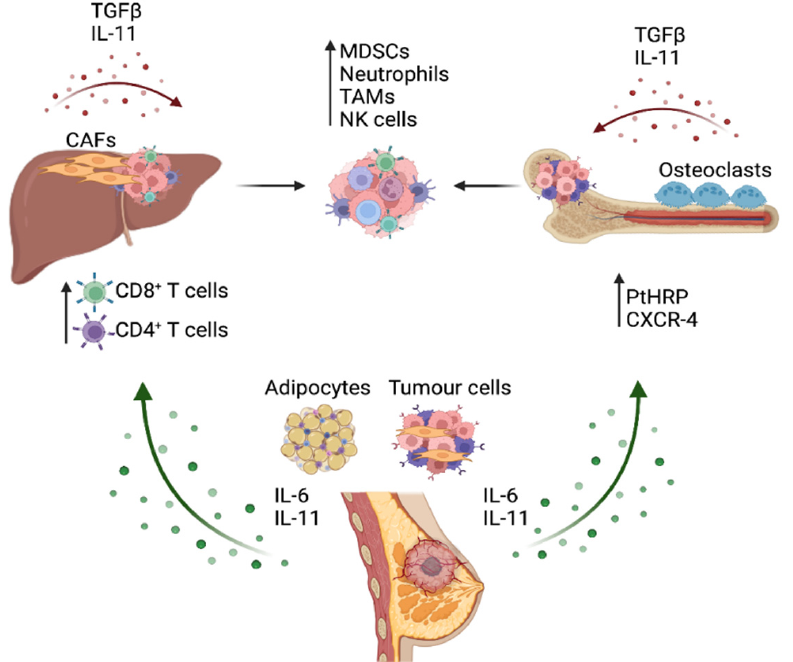
Figure 2. The involvement of IL-6 and IL-11 in the metastatic process in breast cancer. Cellular sources of IL-6 and IL-11 within the tumor microenvironment of the primary tumor in the breast and distal organ sites are illustrated. The excessive secretion of IL-6 and IL-11 support breast cancer development and enable the outgrowth of metastatic lesions in distal sites by promoting either the recruitment or reprogramming of immune cell types. Figure generated in Biorender (Available online: Biorender.com (accessed on 8 December 2021)).